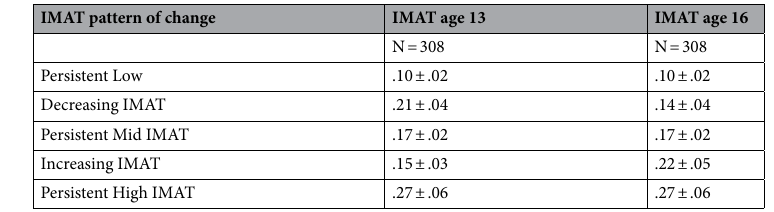
Table 3. Mean proportion of intramuscular adipose tissue of the lumbar multifidus muscle a . a All values are reported as mean ± standard deviation of the maximal proportion of intramuscular adipose tissue